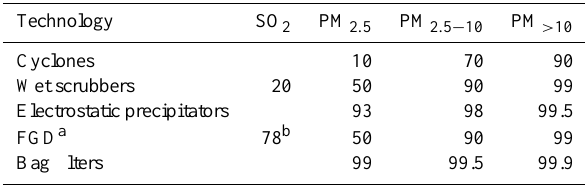
Table 2. Summary of the mass fractions of particulate matter of different size fractions to the total particulate matter in fly ash for different types of boilers a ; values are given as percentages (%).